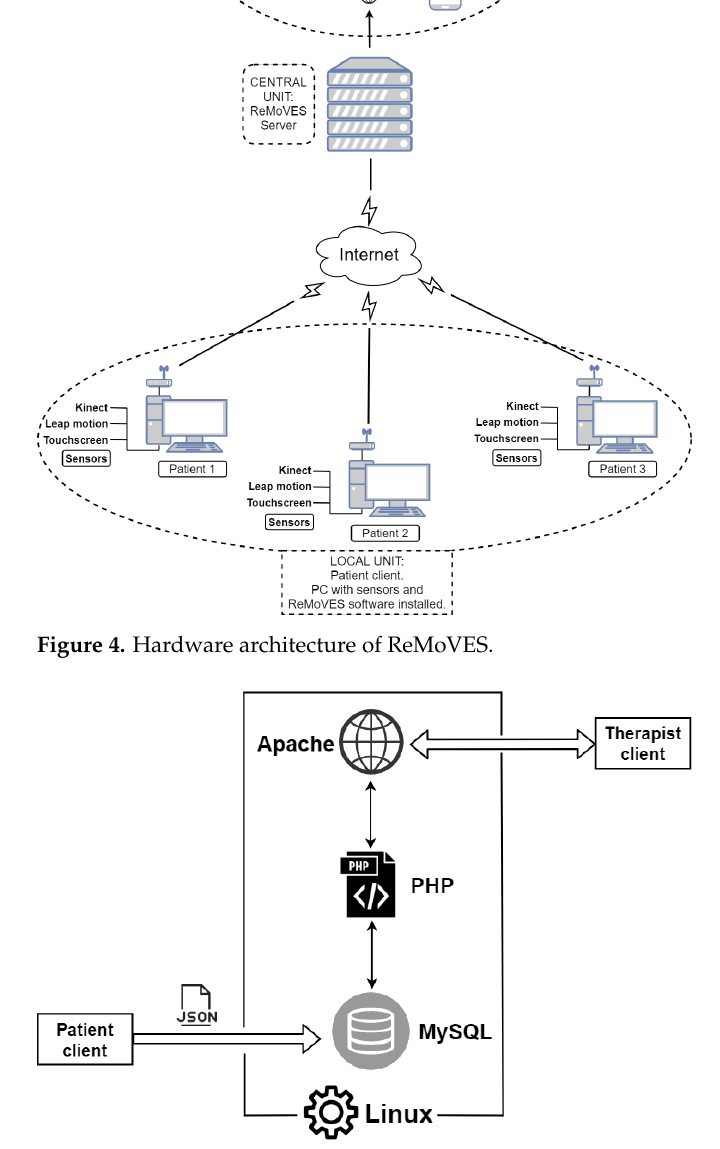
Figure 5. Software architecture of